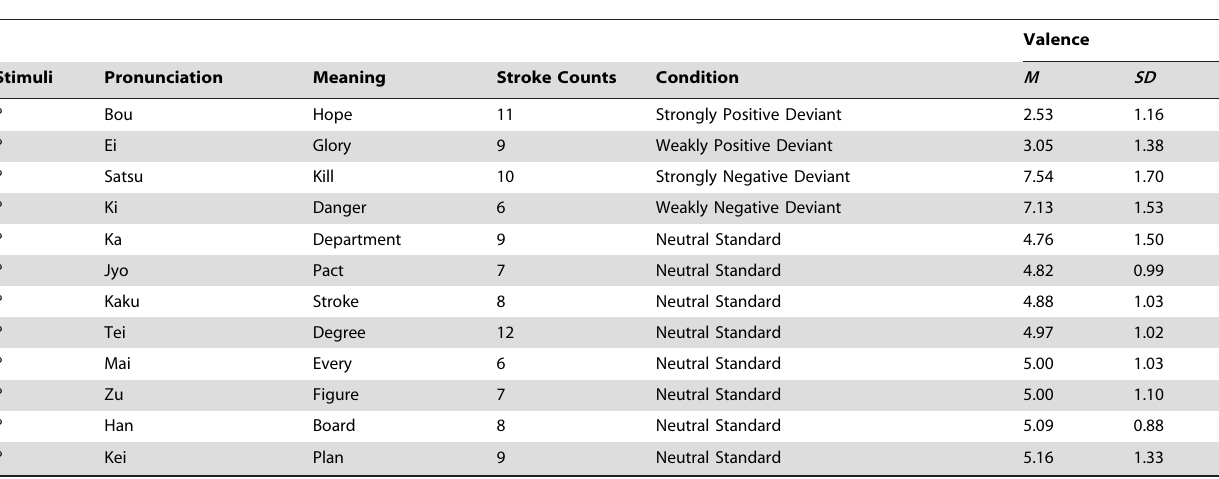
Table 1. Emotional word stimuli in Experiment